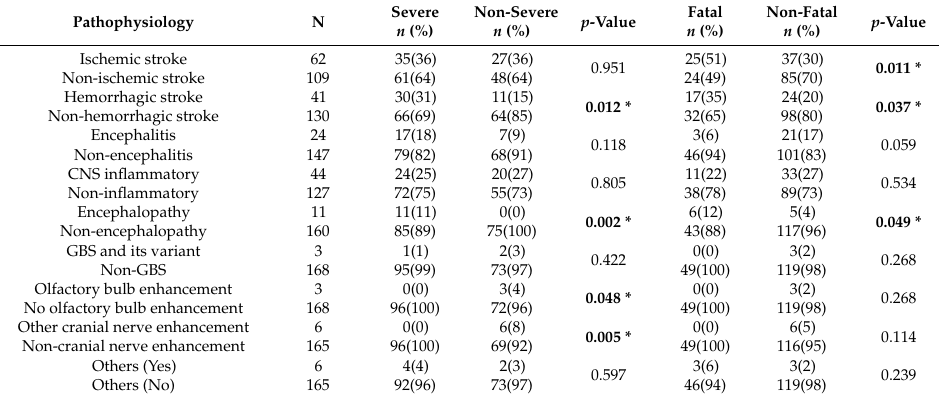
Table 2. Severity and outcomes of COVID-19 based on neurological pathophysiology confirmed through MRI findings for patients ( n = 171).